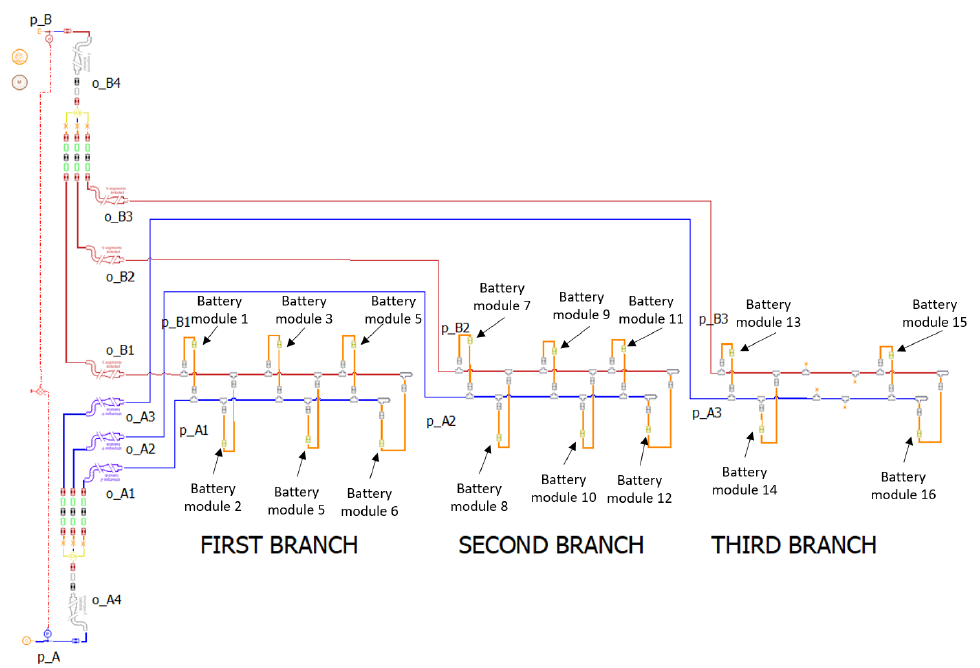
Figure 14. Layout modification: the branch with fewer users is placed as